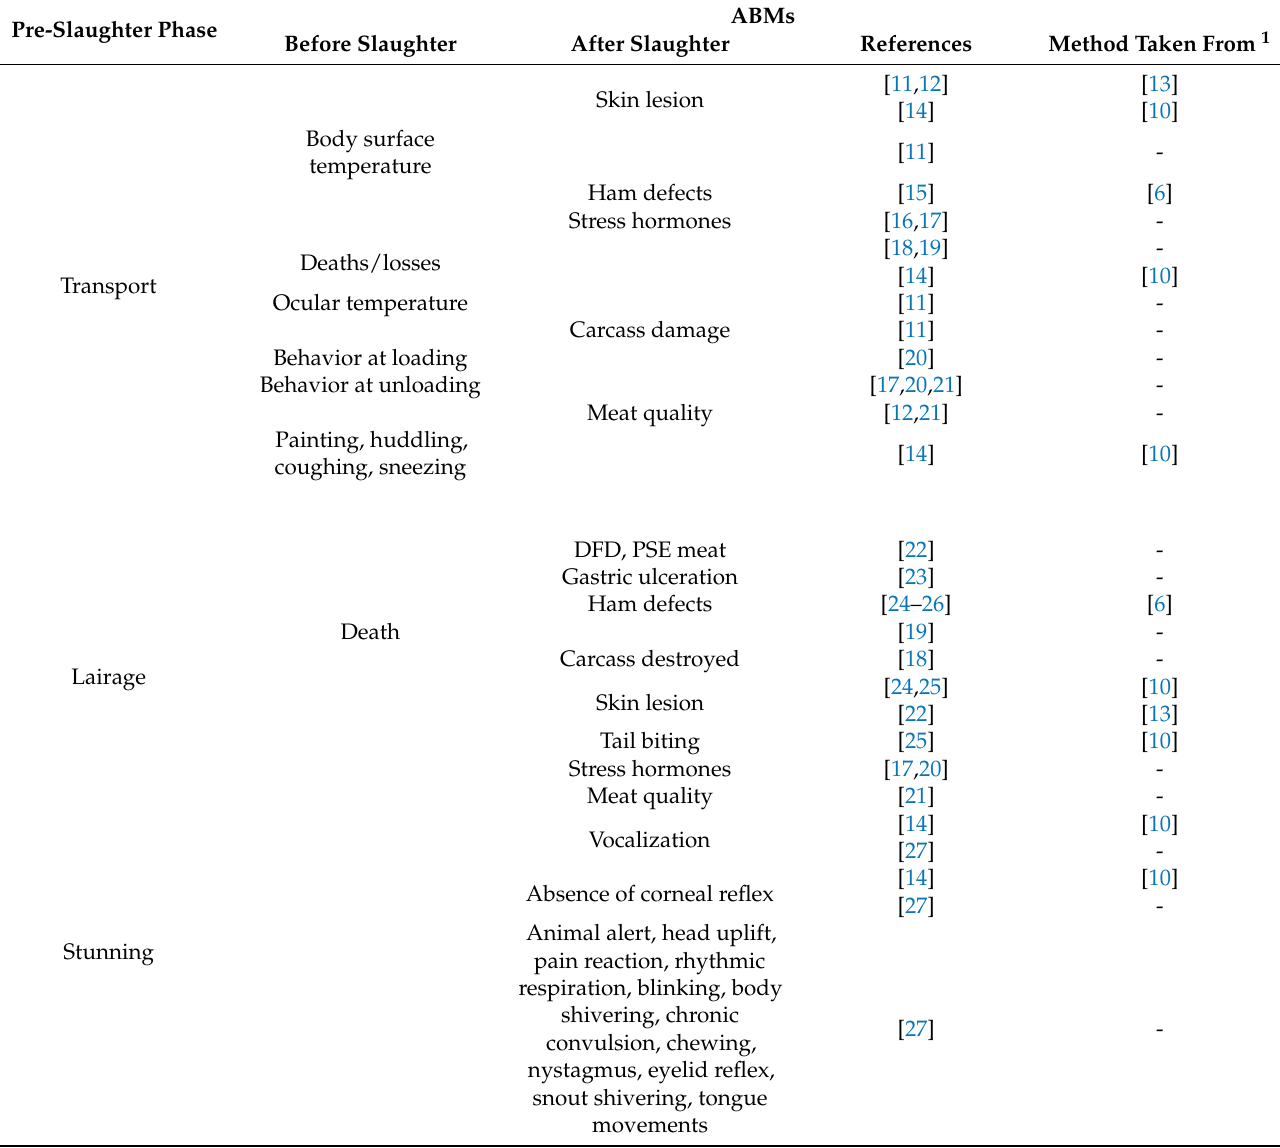
Table 1. Main results of the literature research. The literature was divided according to the pre-slaughter phase. Animal- based measures (ABMs) were classified based on whether they were measured or collected before or after